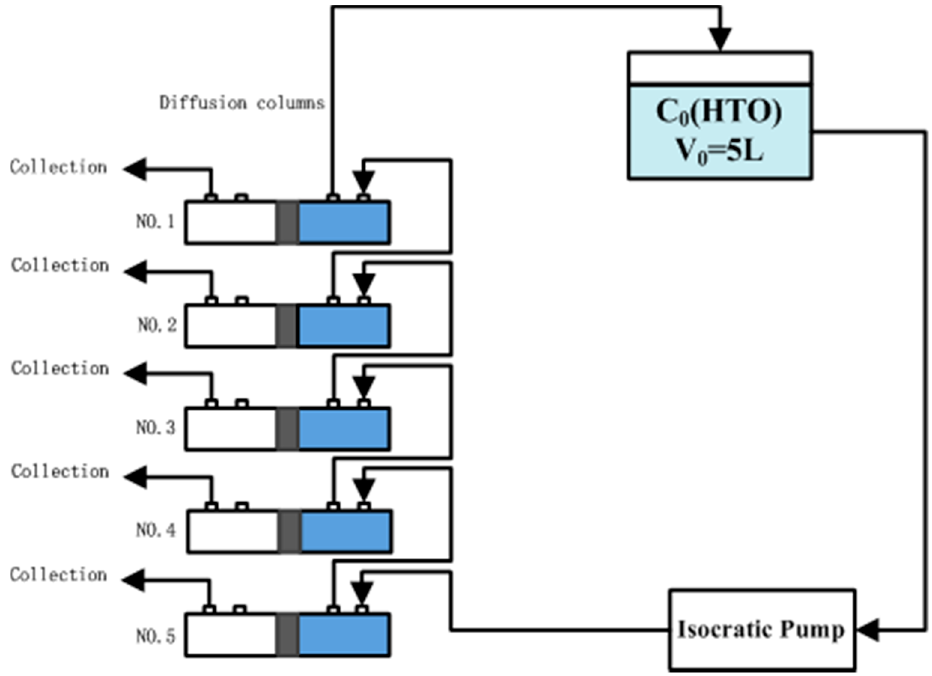
Figure 1. The reliable and precise TD device with a sandwich-like column apparatus used in this study [17–19,22–24].